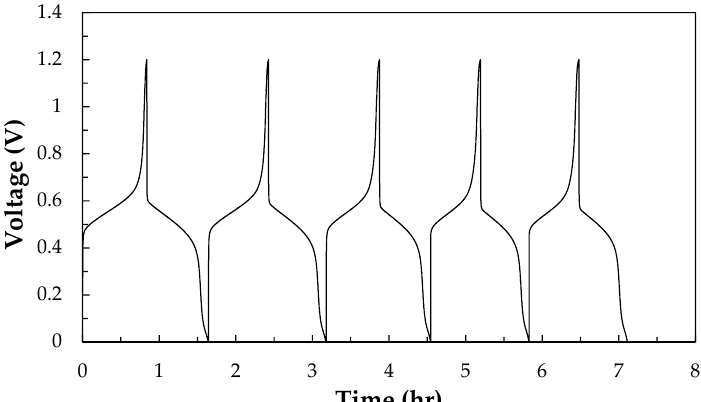
Figure 12. Charge-discharge diagrams of a V / I RFB with modified key materials. The 1.0 M VOSO 4 / 2.0 M H 2 SO 4 was as the positive electrolyte, iodine / ascorbic acid solution as the negative electrolyte, and the C electrode as an anode, the HS-SO 3 H membrane as a separator, the C-TiO 2 -Pd composite electrode as a cathode and using the serpentine-type flow fields at a current density of 20 mA cm − 2 and a flow rate of 60 mL/min.